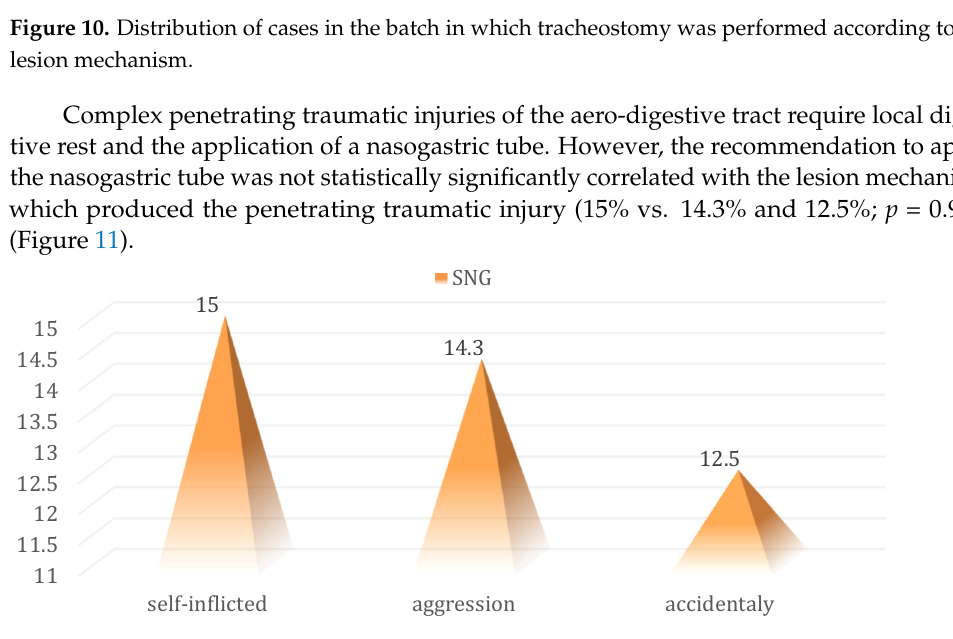
Figure 11. Distribution of cases in the batch to which SNG was applied according to the lesion mechanism.